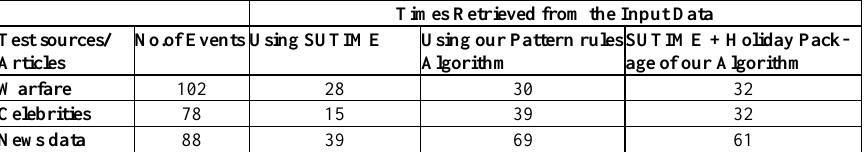
Table 3. Results obtained for the Methods